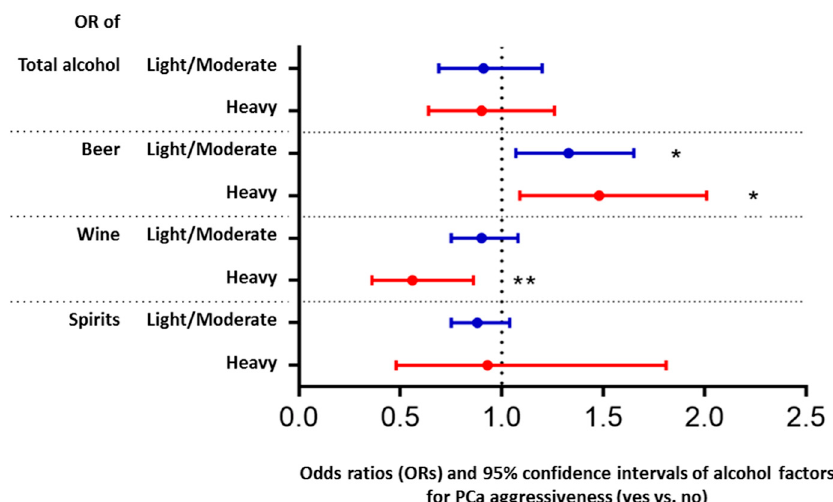
Figure 2. Impact of prostate cancer (PCa) aggressiveness on intake of total alcohol and specific alcoholic beverage types. The results are based on a multinomial logistic model with an alcohol factor (three sub-groups: infrequent, light/moderate, and heavy intake) as the outcome. Factors in the model were PCa aggressiveness status (yes/no), age, BMI, smoking, and region. Odds ratio (OR) and 95% confidence interval of light/moderate (vs. infrequent intake) and heavy (vs. infrequent intake) for PCa vs. non-PCa were shown. *: p < 0.05, **: p < 0.01.